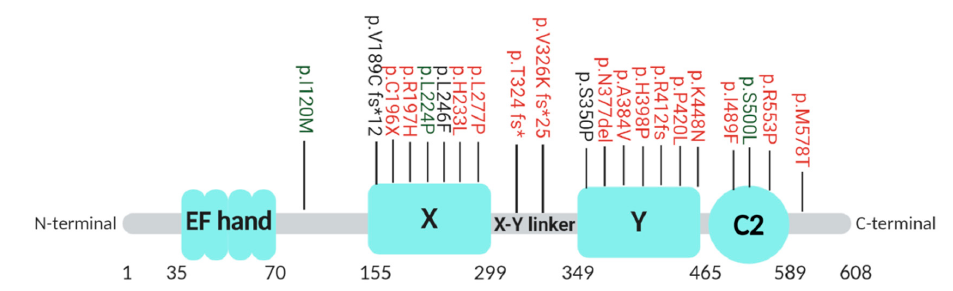
Figure 4. Overview of the localization of the identified mutations in PLC ζ . The amino acid sequence position of the protein domains and the identified mutations are indicated by the numbers. In red, mutations linked to male infertility by functional analysis. In green, mutations not associated to male infertility by functional analysis. In black, mutations not studied by functional analysis